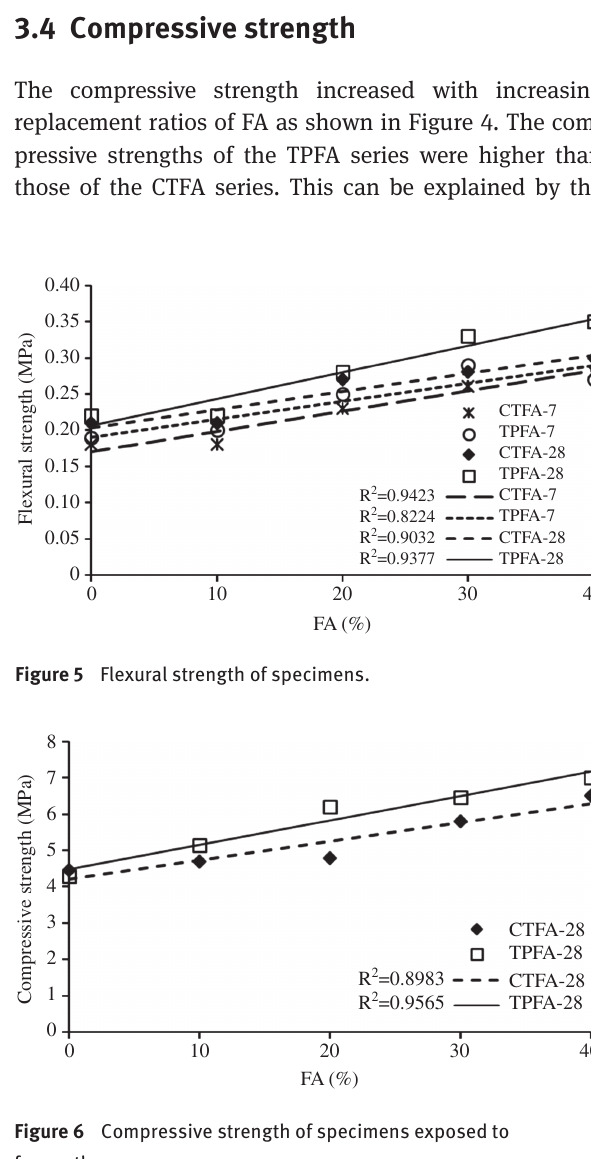
Figure 4 Compressive strength of specimens.